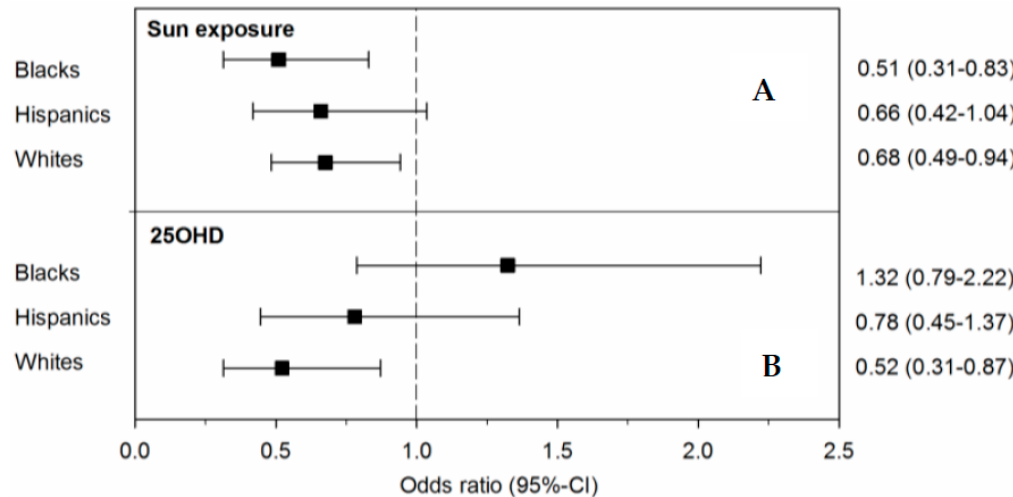
Figure 1. Simultaneous effects of lifetime ultraviolet radiation exposure and 25-hydroxyvitamin D on MS risk. Depicted are the mutually adjusted odds ratios (OR) and 95% confidence intervals (95% CI) of the independent associations of lifetime ultraviolet radiation exposure (Panel A) or serum 25-hydroxyvitamin D levels (Panel B) with risk of multiple sclerosis/clinically isolated syndrome within each racial/ethnic group obtained from the same model. Odds ratios depicted are adjusted by age, sex, smoking, genetic ancestry, HLA–DRB1*15:01 (rs3135388) 25-hydroxyvitamin D (Panel A) or lifetime ultraviolet radiation exposure (Panel B). Serum 25-hydroxyvitamin D levels were log transformed, adjusted for BMI and deseasonalized.